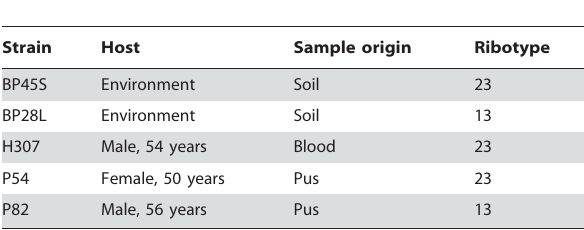
Table 4. B. pseudomallei isolates used for DNA